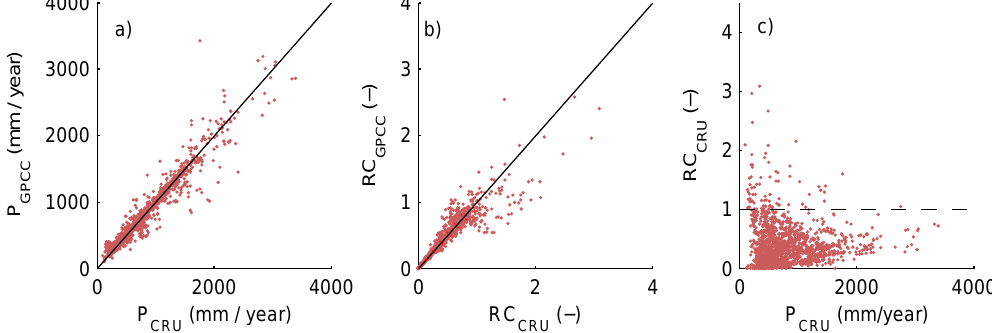
Fig. 6. (a) Relation between GPCC and CRU precipitation, (b) best RC estimates based on GPCC precipitation versus CRU precipitation, and (c) best RC estimates based on CRU precipitation versus CRU precipitation. The 45 ◦ lines indicate the 1 : 1 quotient and the dashed line indicate RC=1.